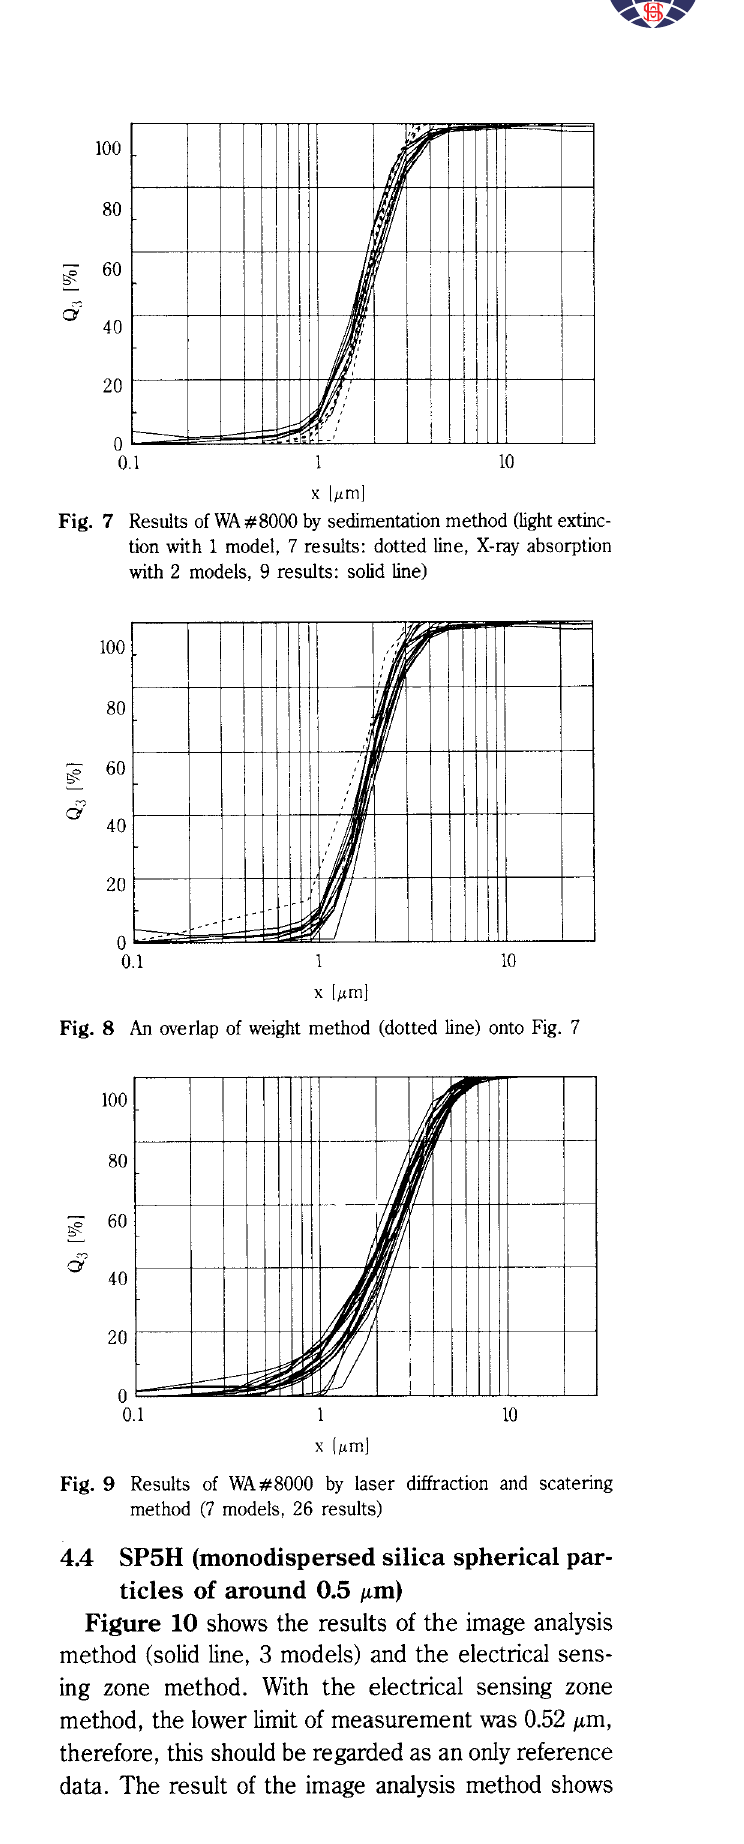
Fig. 6 Results ofWA#8000 by the electrical sensing zone method (dotted line: 2 results) and the optical blockage method (solid line: 6 results)